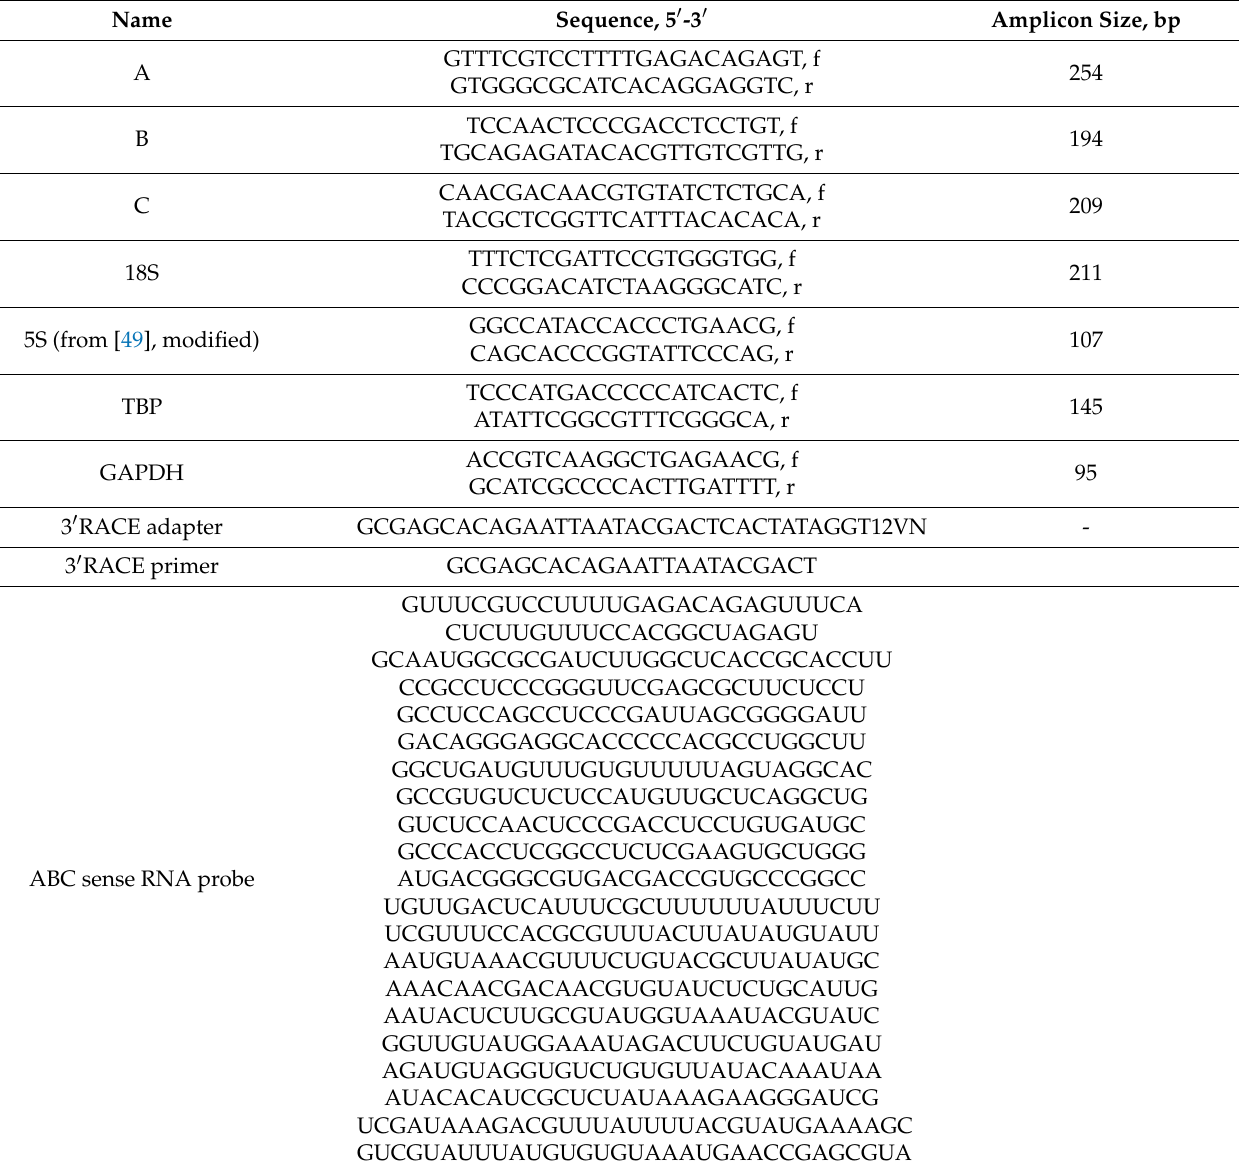
Table A1. The sequences of primers and